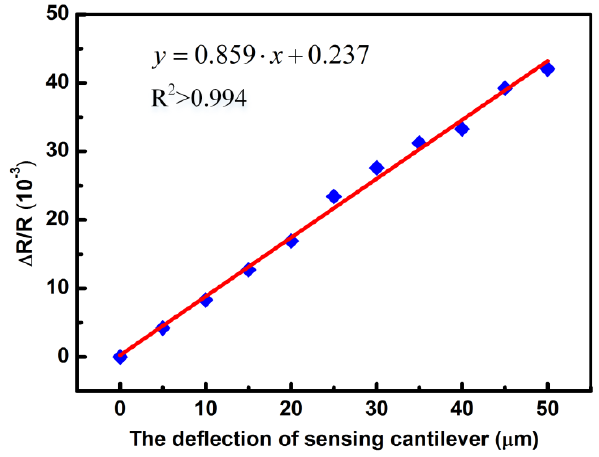
Figure 5. The relative resistance changes of PEDOT/PSS piezoresistor measured for net deflection